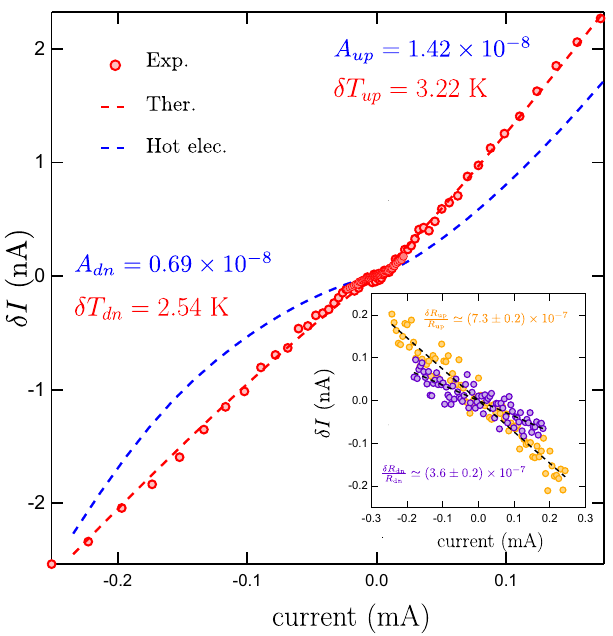
Fig. 5 Current dependence of the photon-assisted current. Photon- assisted current as a function of dc current with the same experimental settings as Fig. 4. Symbols are experimental data. Blue dashed line is the numerical simulation from eqs. (6) and (8) dealing with ''hot carrier" distribution in the electrodes whereas the red dashed line corresponds to two different thermal distributions in the contacts described. Inset : photon- induced current measured in the upper (orange circles) and lower contacts (purple